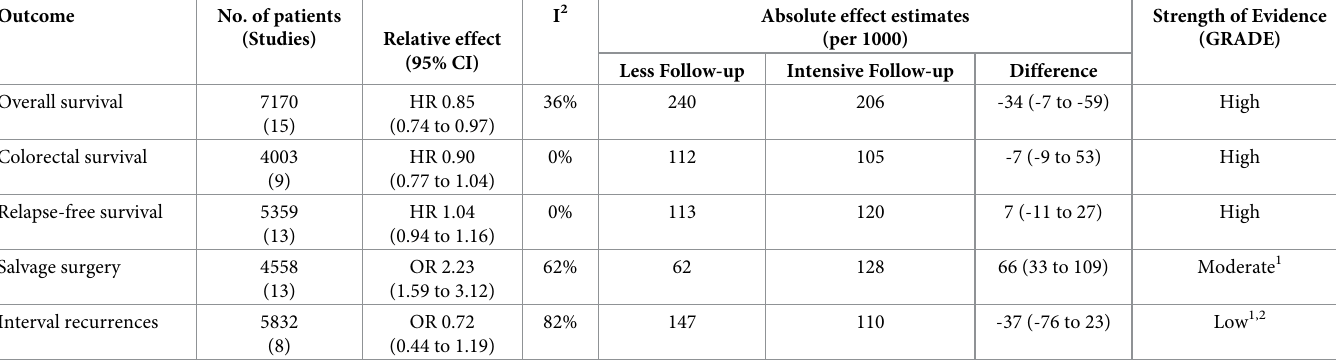
The associations between intensive versus less follow-up and overall survival are shown in Fig 2. Fifteen trials reported outcomes of all-cause mortality. Overall, all-cause mortality was 21.7% (784/3604) in the intensive follow-up group and 24.0% (857/3566) in the less follow-up group (OR 0.82, 95% CI 0.70–0.96; I 2 = 29%). Forteen trials reported the data of time-to-event. Pooled HR showed a protective effect of an intensive follow-up strategy on overall survival (HR 0.84, 95% CI 0.74–0.96; I 2 = 33%; high quality). Funnel plot analysis did not suggest any asymmetry (Fig 3), and the Egger test did not detect significant publication bias (P = .11). Moreover, TSA confirmed that the required information size was met (S1 File) Table 2. Summary of findings and strength of evidence in studies of the effects of intensive follow-up among patients with nonmetastatic colorectal